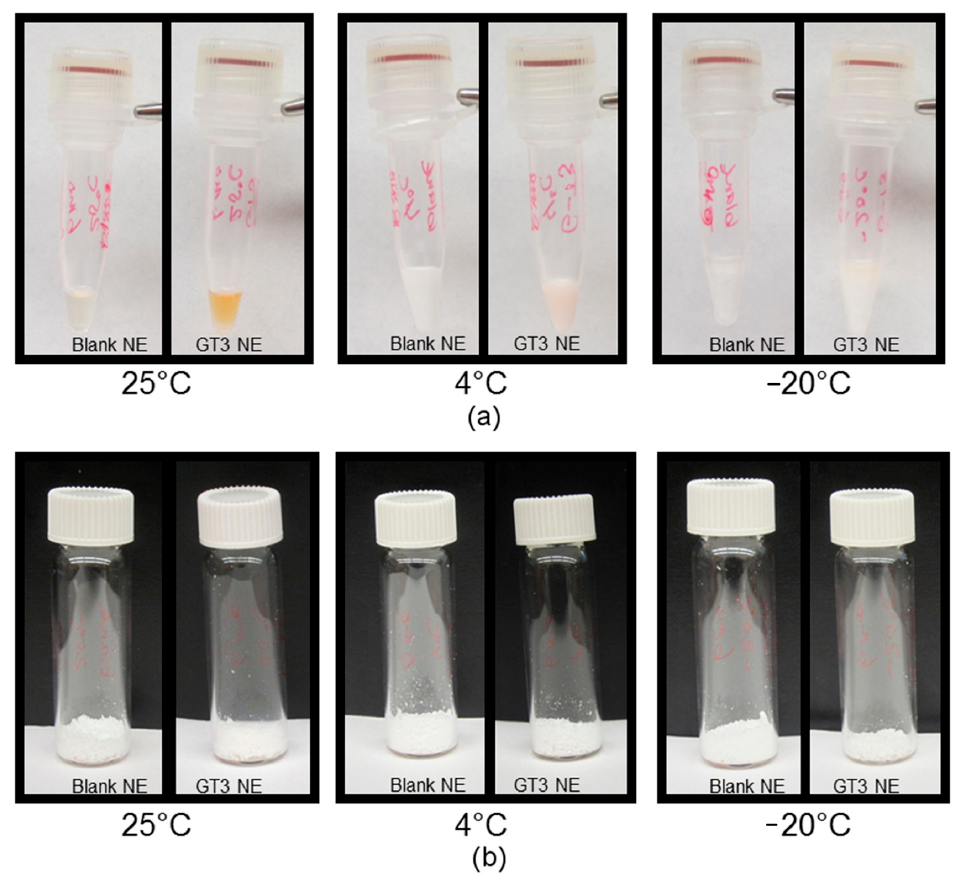
Figure 6. Comparison of ( a ) liquid and ( b ) lyophilized NE with and without GT3 after 24 weeks of storage at 25, 4, and − 20 °C. storage at 25, 4, and − 20 ◦